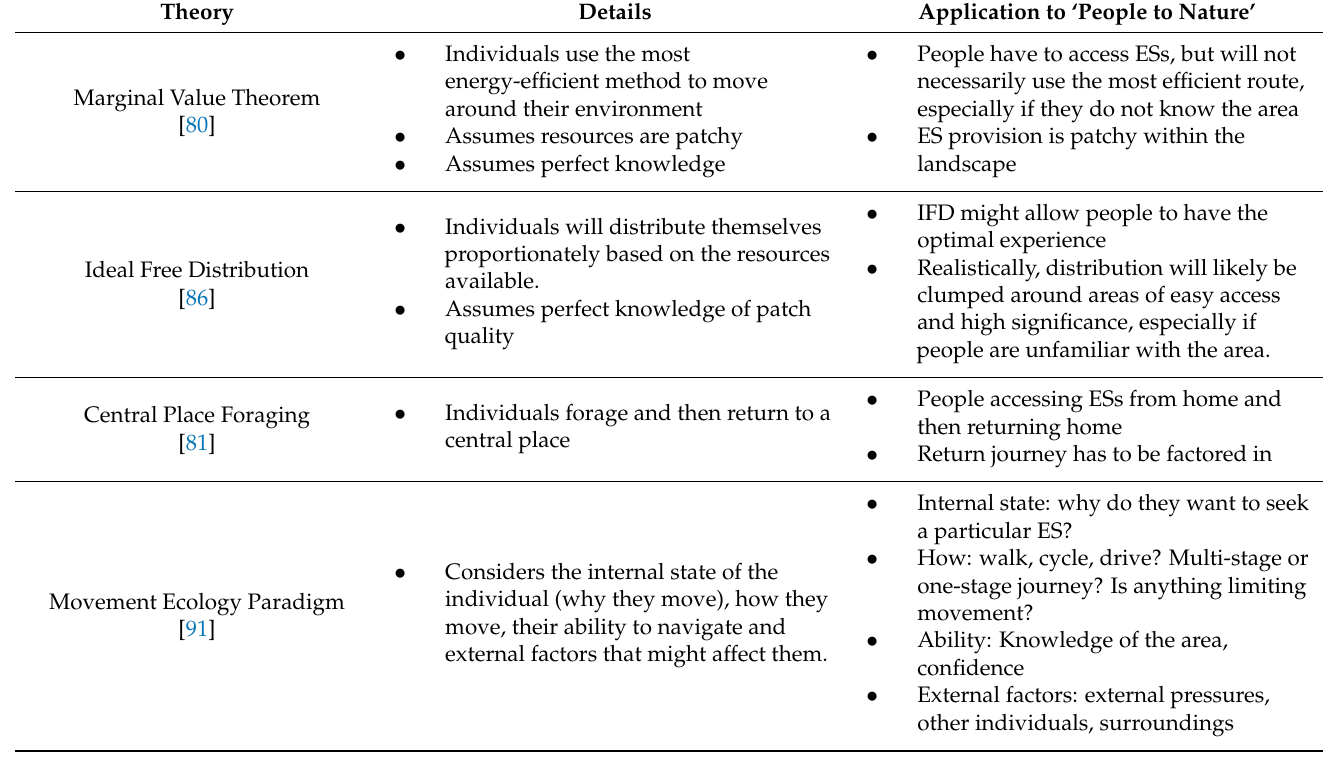
Table 3. Summary of foraging theories and potential applications to ‘people to nature’ (the movement of beneficiaries to a transactor in search of an ecosystem